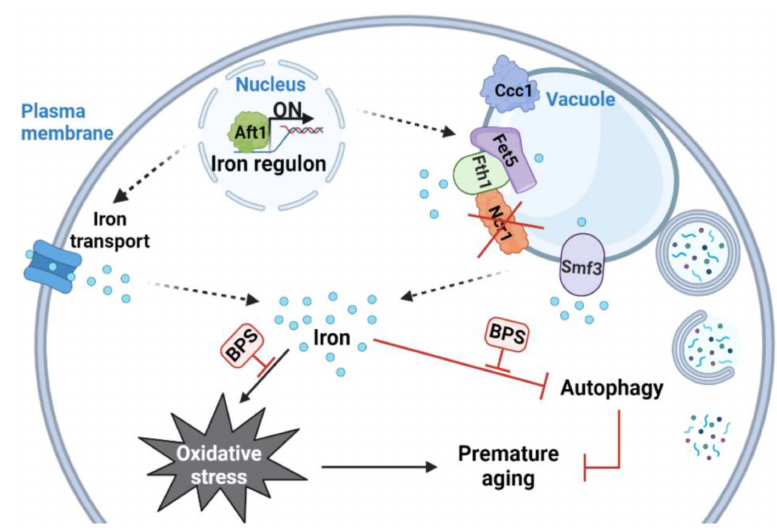
Figure 7. Working model. Absence of Ncr1 leads to Aft1 activation, increasing the transcription of the iron regulon and causing iron dyshomeostasis. Our results show that the levels of vacuolar iron exporters (Fet5, Fth1, and Smf3) increase in vacuolar membranes of ncr1 ∆ cells. The expression of plasma membrane iron transporters may also be induced (due to Aft1 activation), but this remains to be demonstrated. Iron accumulation promotes oxidative stress and blocks autophagy. Iron limitation, by treating cells with BPS, decreases oxidative stress, restores the autophagic flux, and, consequently, improves the lifespan in the yeast model of NPC1. Dashed arrows represent cellular functions and mechanisms demonstrated in other